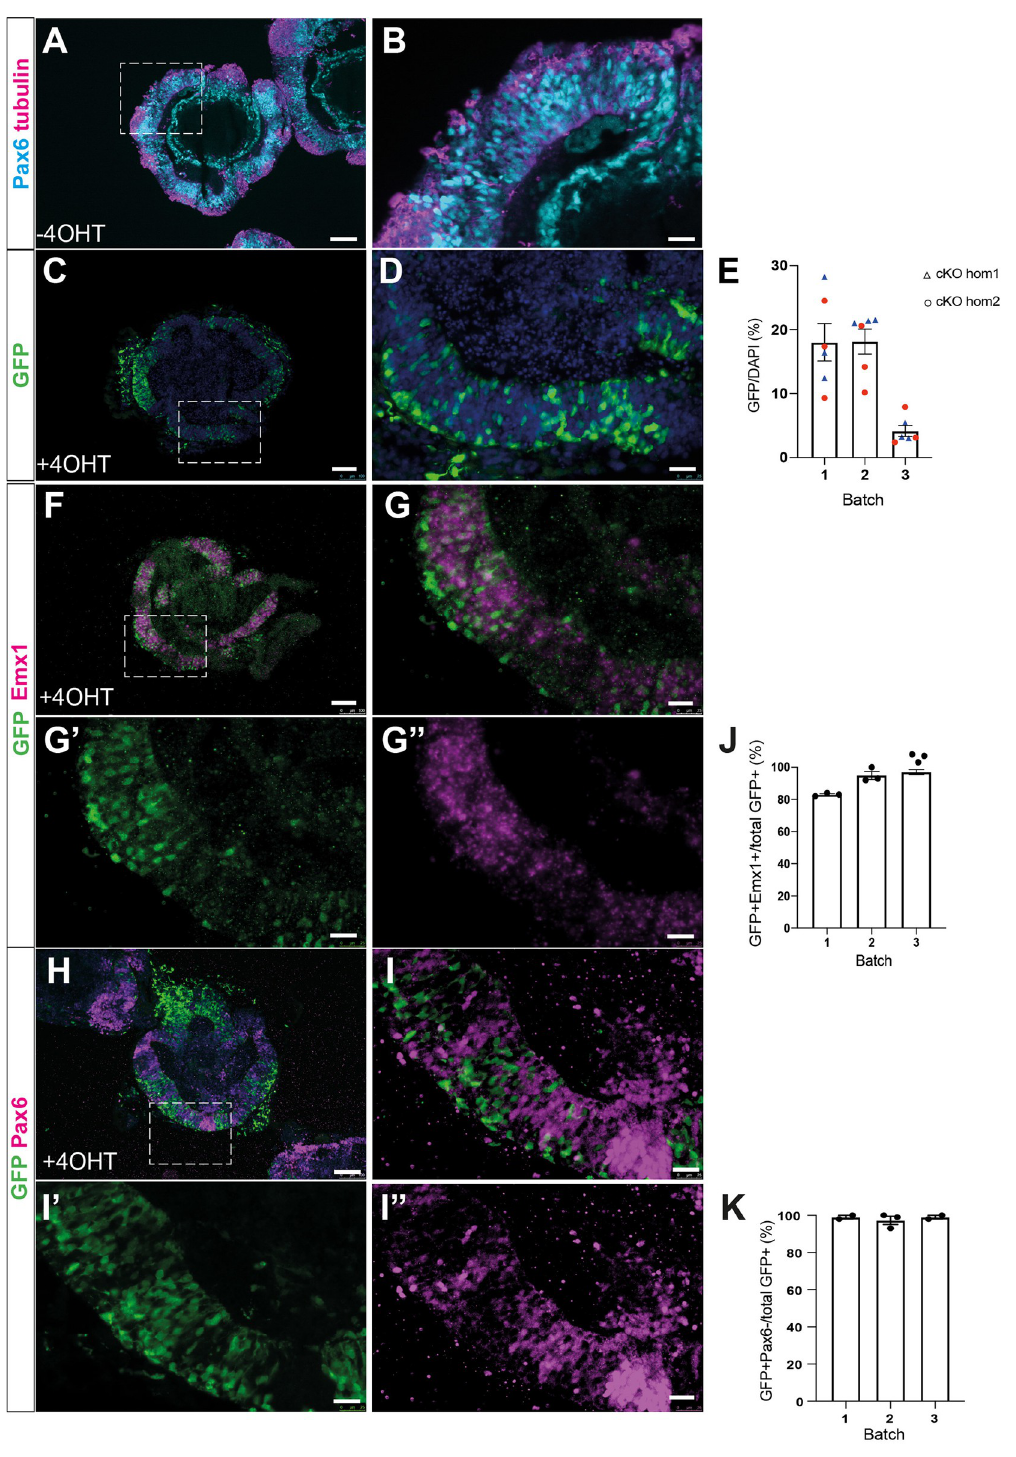
Fig 3. Characterisation of Pax6 cKO cerebral organoids. (A,B) Pax6 and β -tubulin expression in day 8 cKOhom1 organoids treated with DMSO vehicle only. The boxed area in panel A is shown in B. (C,D) GFP staining of 4OHT treated organoids, showing mosaic activation of cre reporter in neuroepithelium. The boxed area in panel C is shown in D. (E) Quantitation showing efficiency of GFP-reporter activation in 4OHT treated cKOhom1 and cKOhom2 organoids. (F,G) Combined in situ hybridization for Emx1 (magenta) and GFP immunostaining, showing mosaic activation of the cre-reporter RCE in cells with